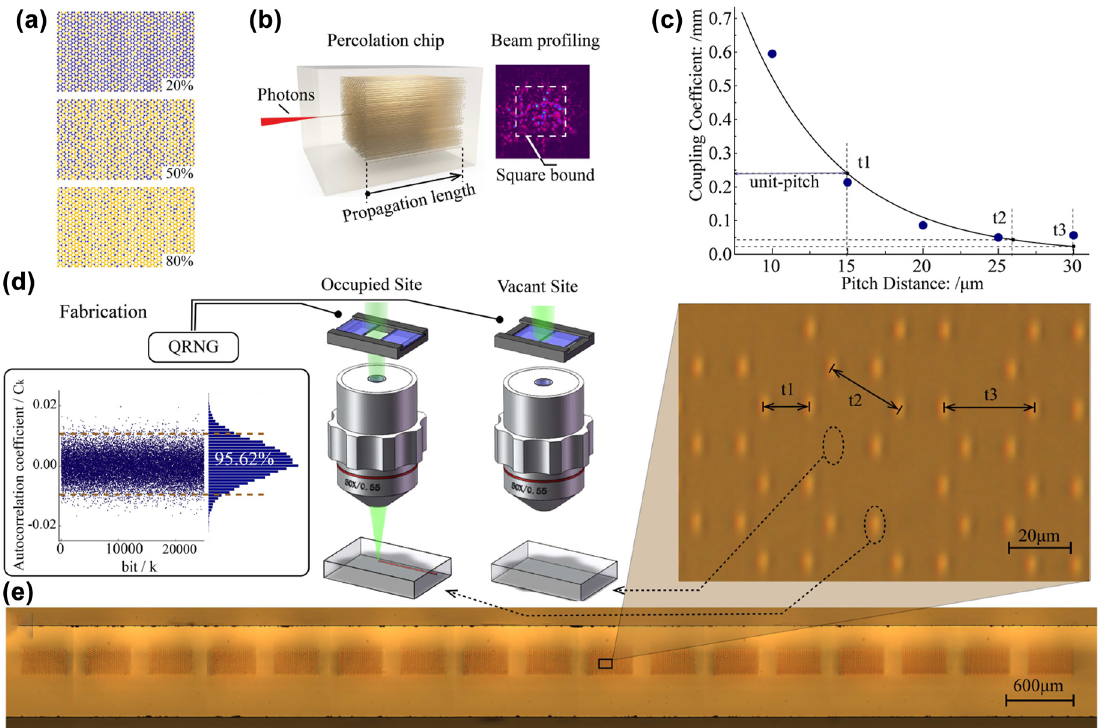
Figure 2: Constructing large-scale percolation lattices on a photonic chip (a) schematic lattices with different occupation probabilities. Yellow and purple sites denote occupied and vacant respectively. (b) Schematic of the quantum percolation experiment. Photon injected into a central waveguide evolves in the percolation waveguide structure. The transverse distribution at the output is collected by an optical beam profiler. (c) The relation between pitch distances and coupling coefficients. The blue dots are experimental data. (d) Programmable fabrication of percolation lattice. A shutter is linked to a quantum random number generator (QRNG) to control the writing laser on and off. The independence and randomness of occupied distribution are ensured when the random number can well pass the autocorrelation test. (e) The cross-sections of seventeen 85 % -occupied percolation lattices are pictured. The inset shows the zoomed picture for part of a